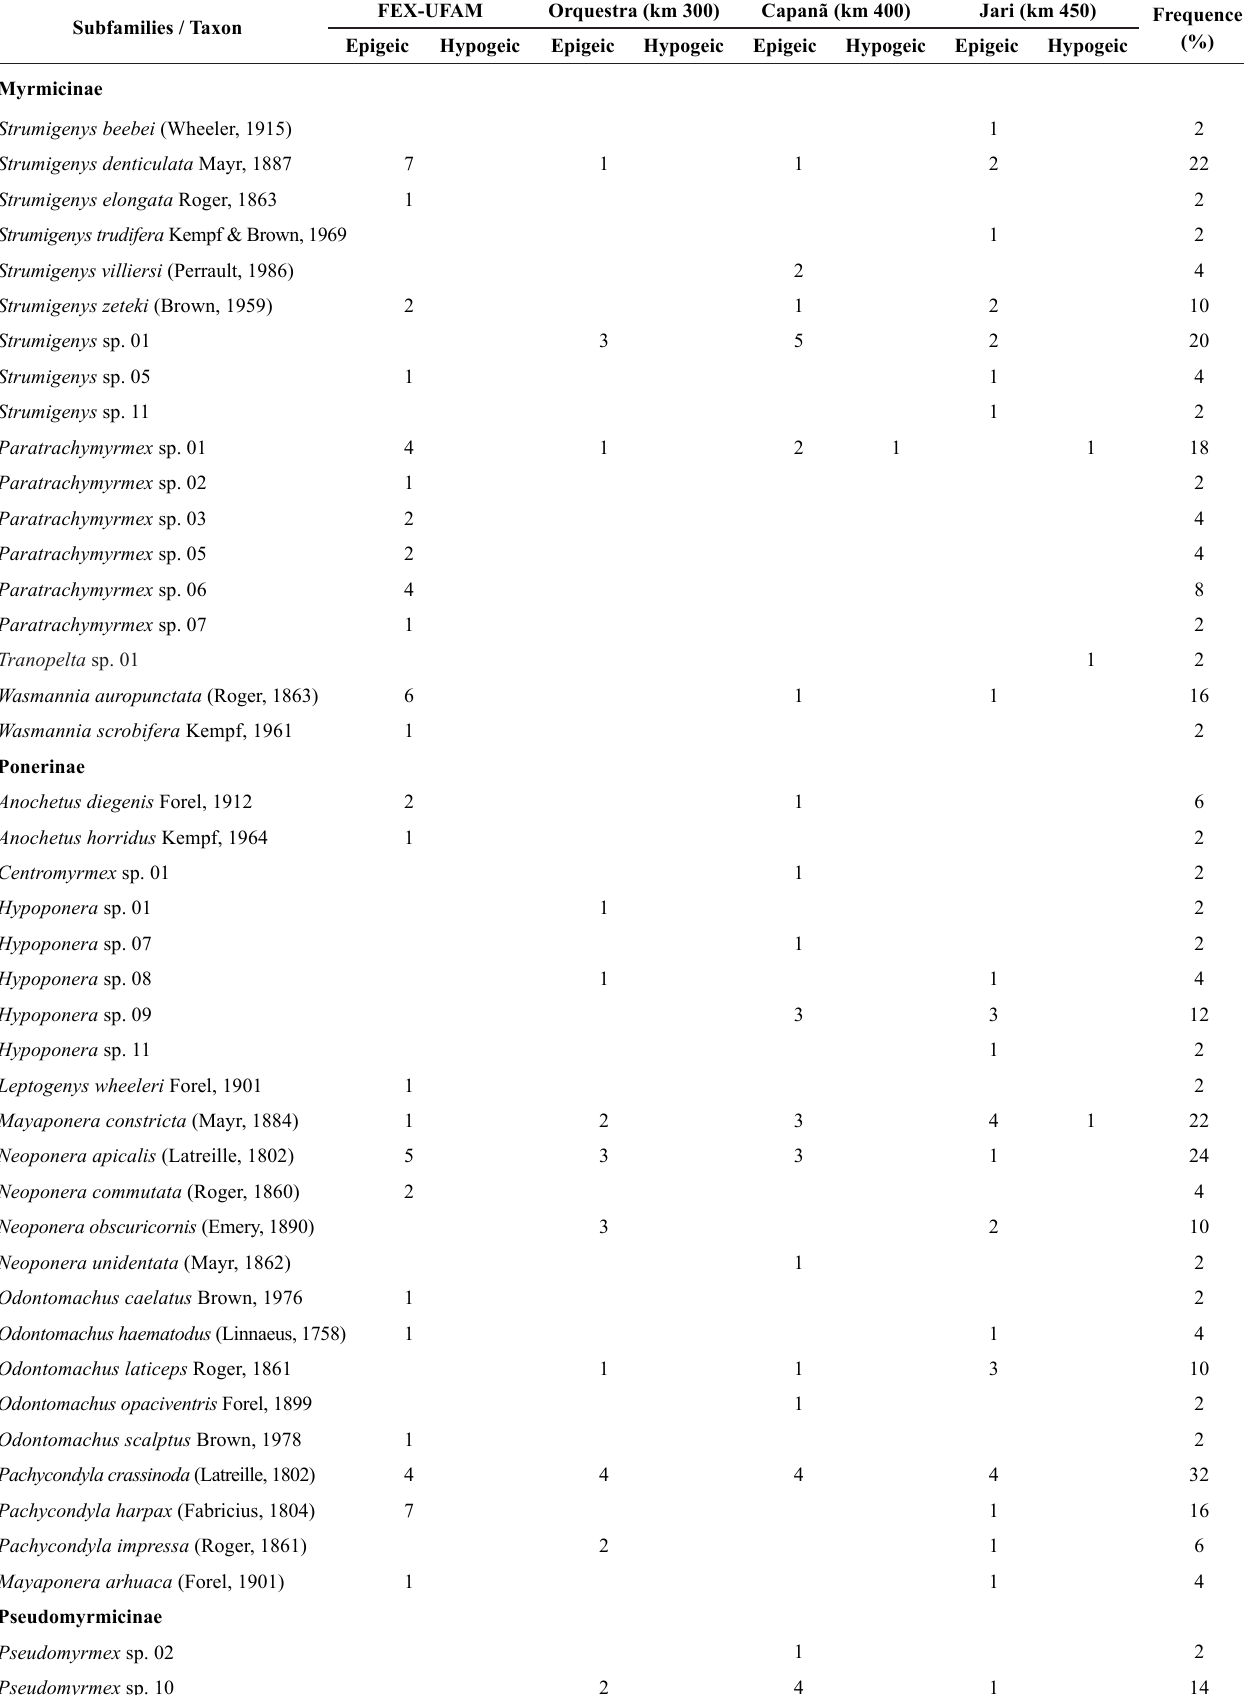
Table 2 . Occurrence and frequency of ant species and morphospecies sampled in the hypogeic (10 plots) and epigeic (7 plots) strata at UFAM and on BR 319 modules Orquestra, Capanã and Jari (5 plots in both strata for each site). (Continuation) Subfamilies /